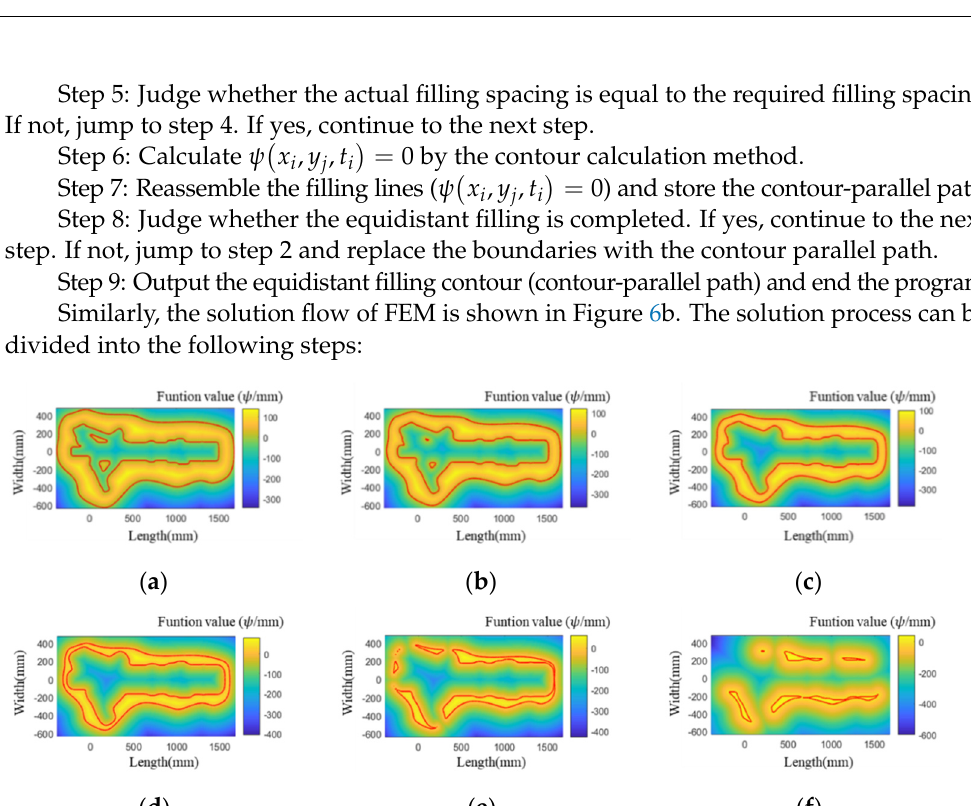
( b ) Figure 5. Flow chart of the new contour parallel path generation algorithm using different methods: ( a ) FDM; ( b ) FEM. Similarly, the solution flow of FEM is shown in Figure 6b. The solution process can be divided into the following steps: Step 1: Input the time increment ∆ t , the moving speed F, the element size, and the